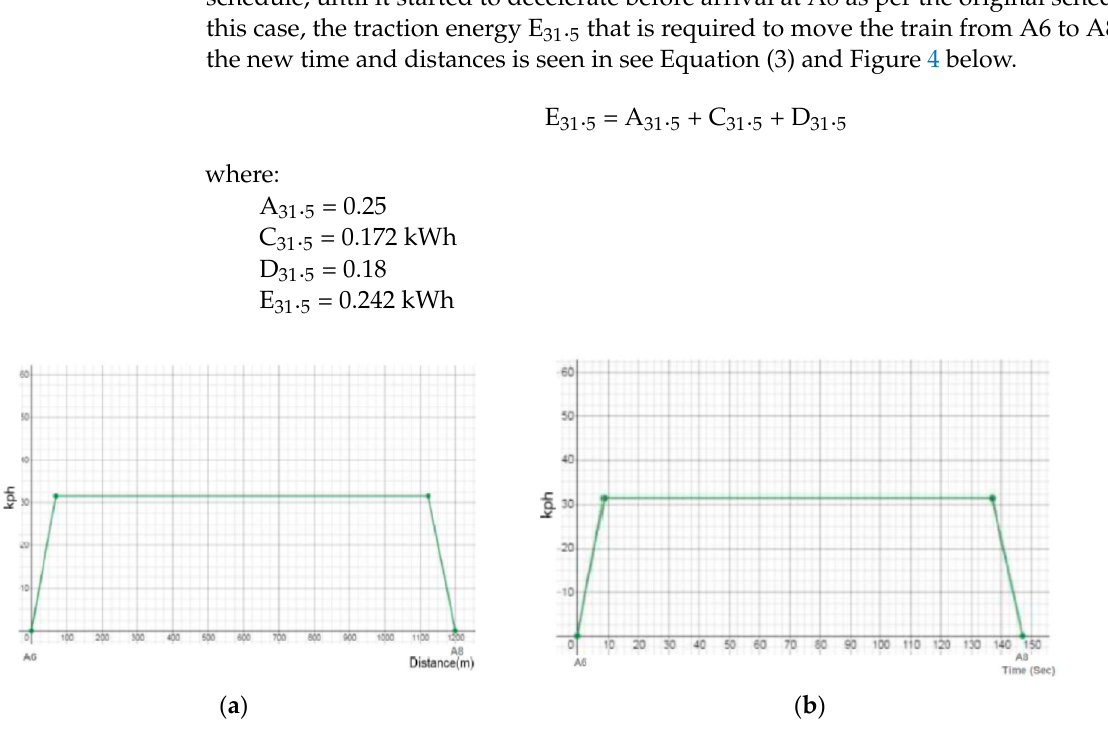
Figure 4. A schematic diagram represents the train movement (distance ( a ) and time ( b )) from A6 to A8 directly without stopping at A7.